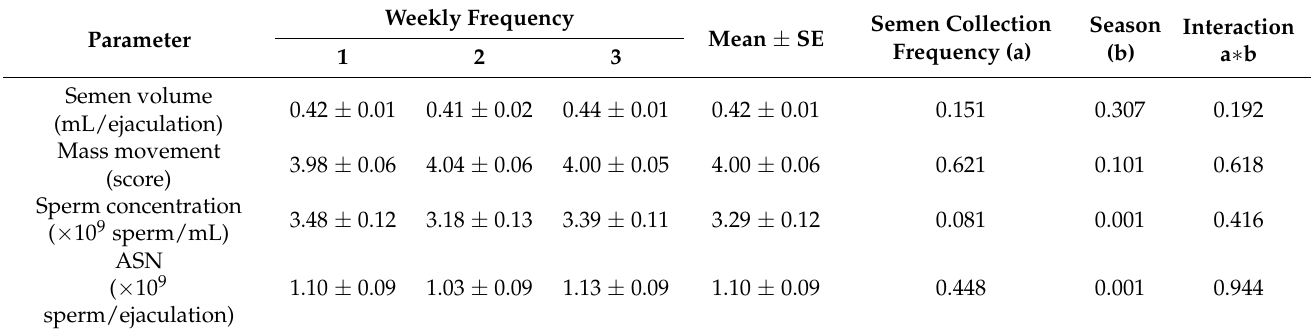
Table 2. Effect of semen collection frequency and season and their interaction on semen volume, mass movement, sperm concentration, and average sperm number of fresh rooster